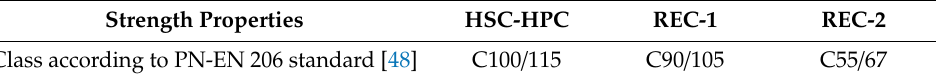
Table 10. Characteristics of the recycled aggregate concrete and the HSC-HPC concrete.